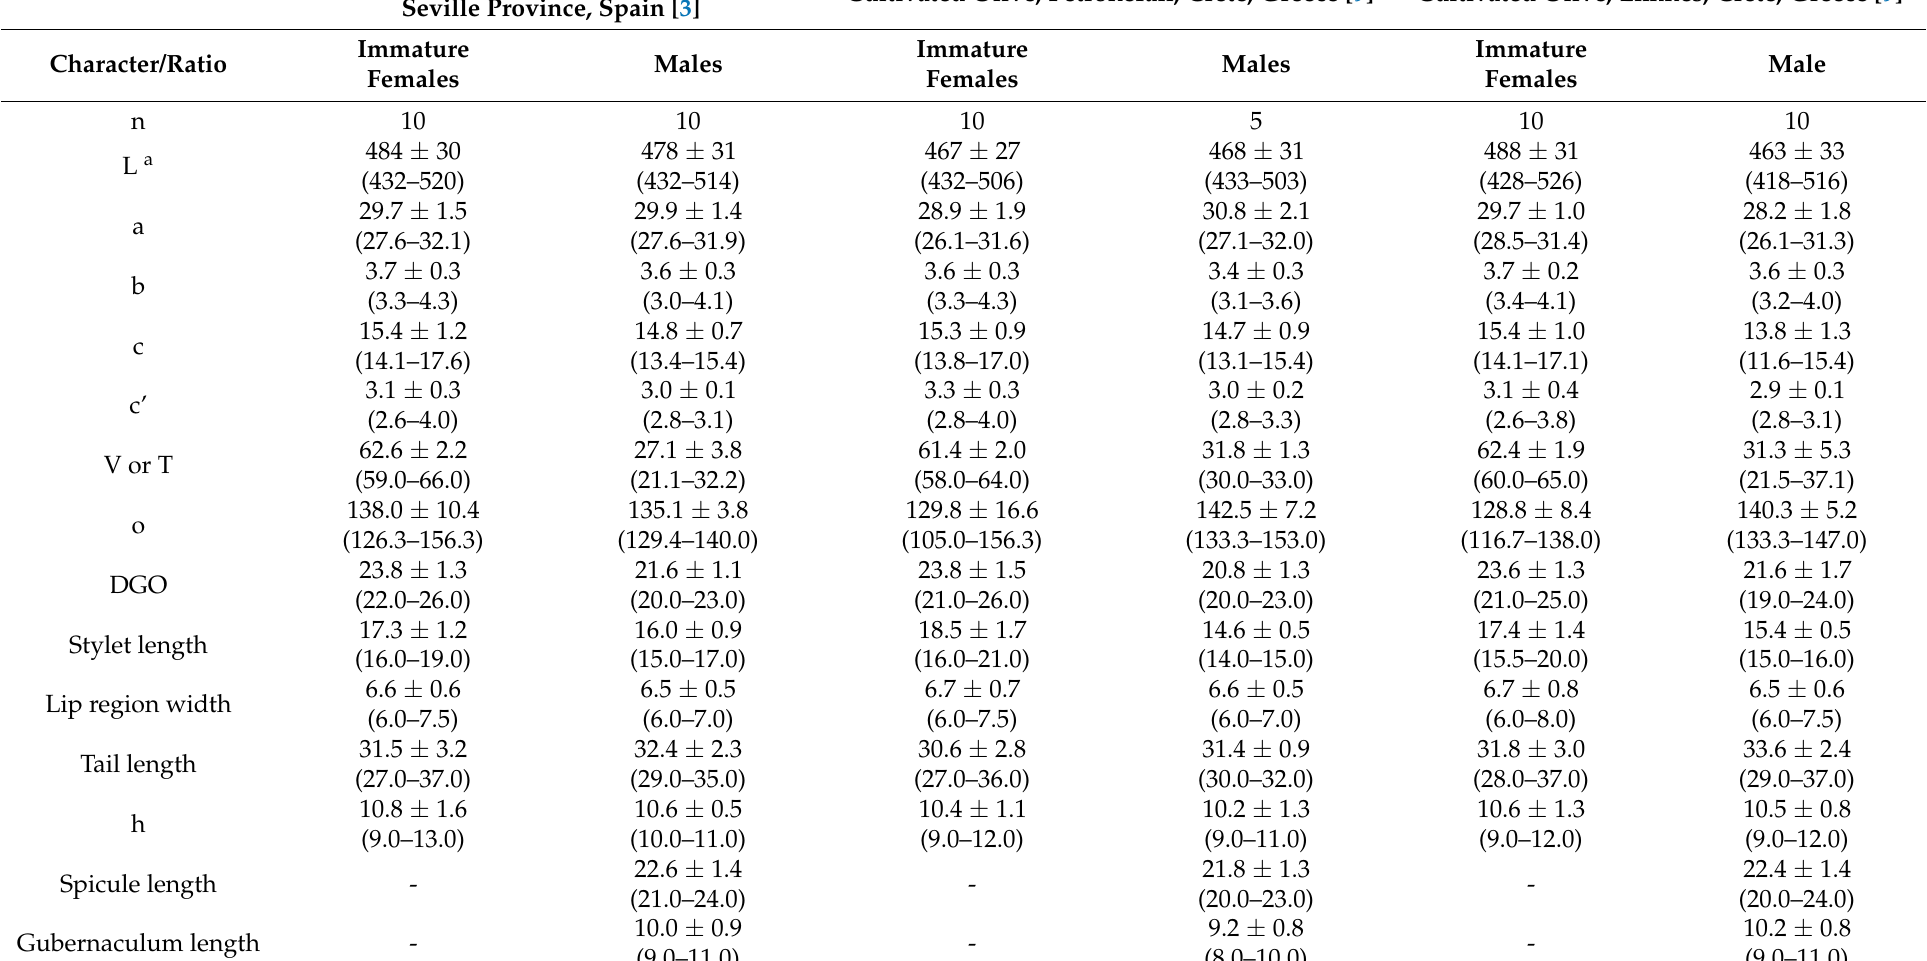
Table 6. Measurements of immature females and males of Rotylenchulus borealis (= R. macrosoma) from cultivated olive in Spain and Crete, Greece. All measurements are in micrometers and in the form mean ± SD